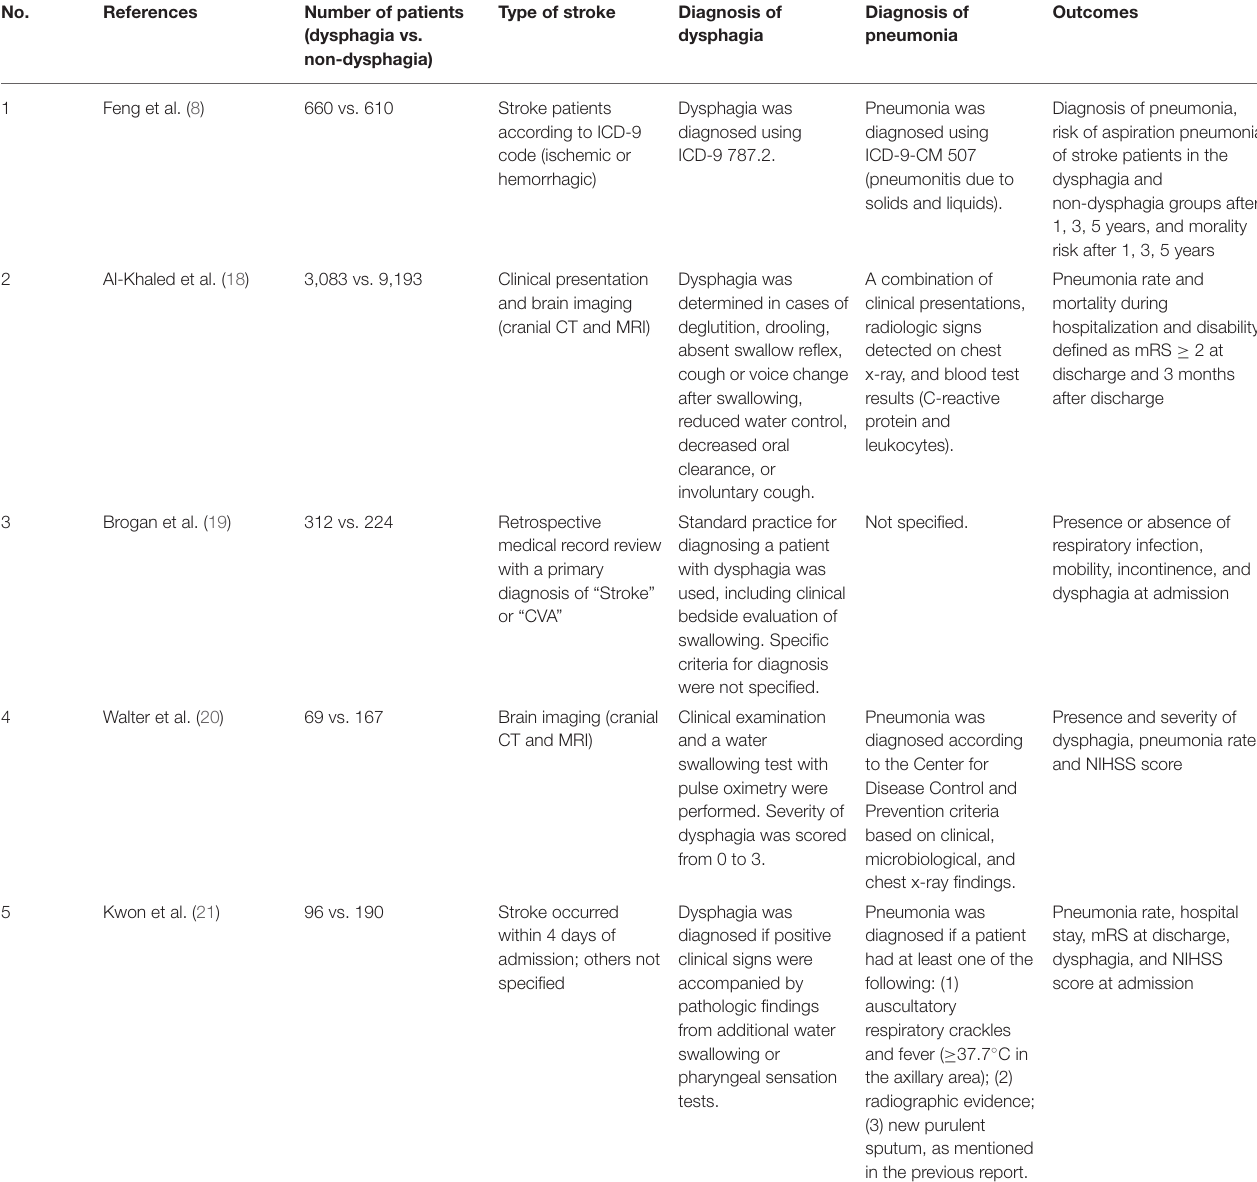
TABLE 1 | Characteristics of included